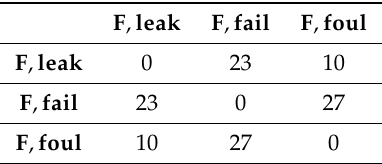
Table 12. Isolability performance